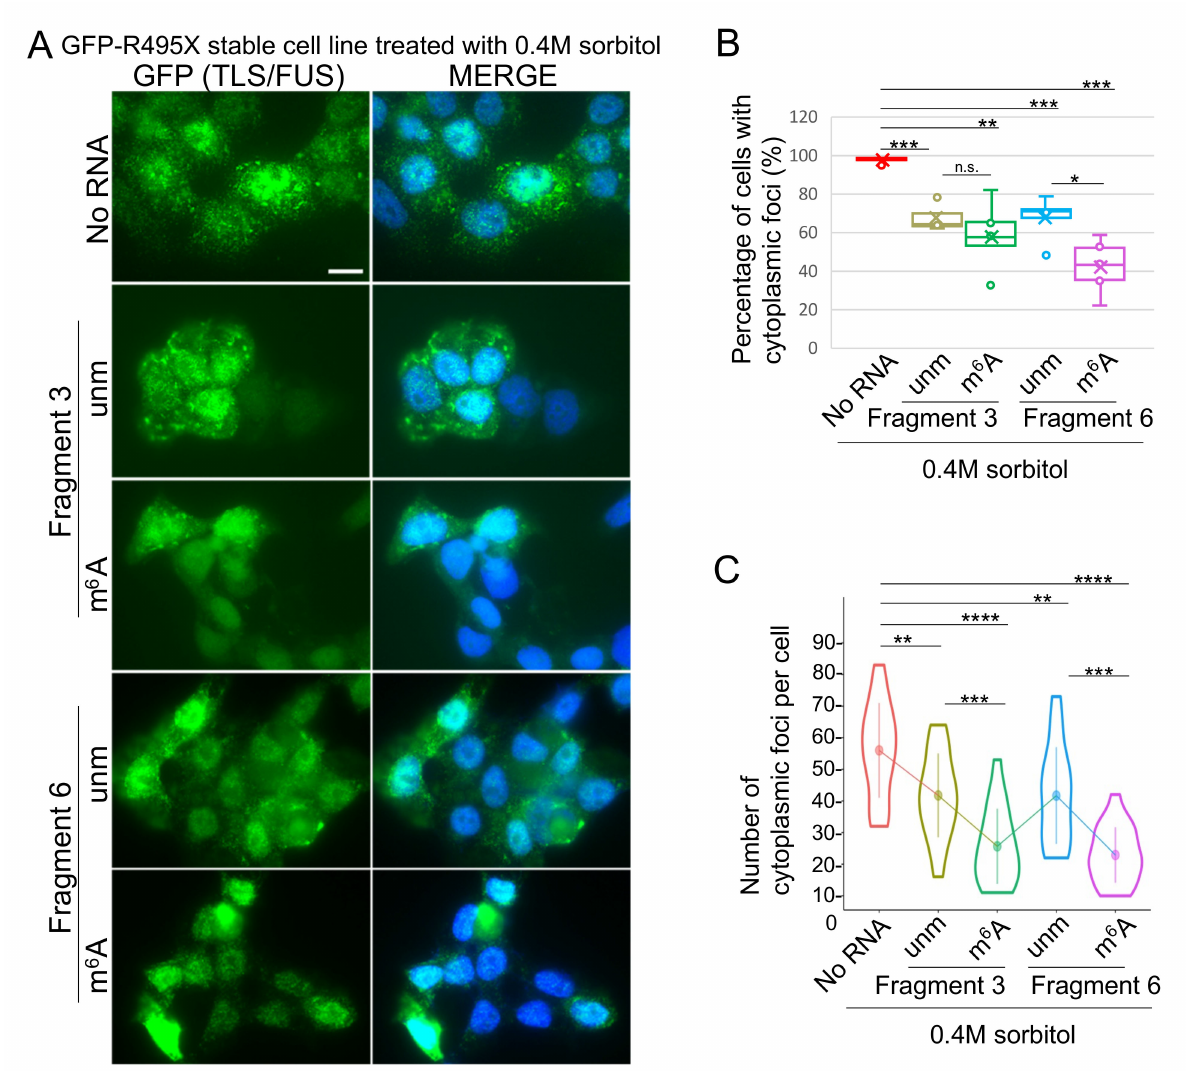
Figure 4. RNA fragments reduced cytoplasmic GFP-R495X foci after sorbitol treatment. ( A ) Stable cell lines expressing GFP-R495X were transfected with RNA Fragments 3 and 6 with or without m 6 A modification prior to sorbitol treatment. GFP signals were detected as TLS/FUS localization. MERGE images indicate the layered images of GFP and DAPI (for nuclei staining). Scale bar = 10 µ m. ( B , C ) Percentage of cells with cytoplasmic TLS/FUS foci ( B ) or number of cytoplasmic foci per cell ( C ) were counted and quantified using images in ( A ) and Supplementary Materials Figure S5. n = 10 ( B ) or 50 ( C ) for each sample. n.s., not significant; unm, unmodified fragments; m 6 A, m 6 A modified fragments. * p < 0.05, ** p < 0.01, *** p < 0.005, **** p <